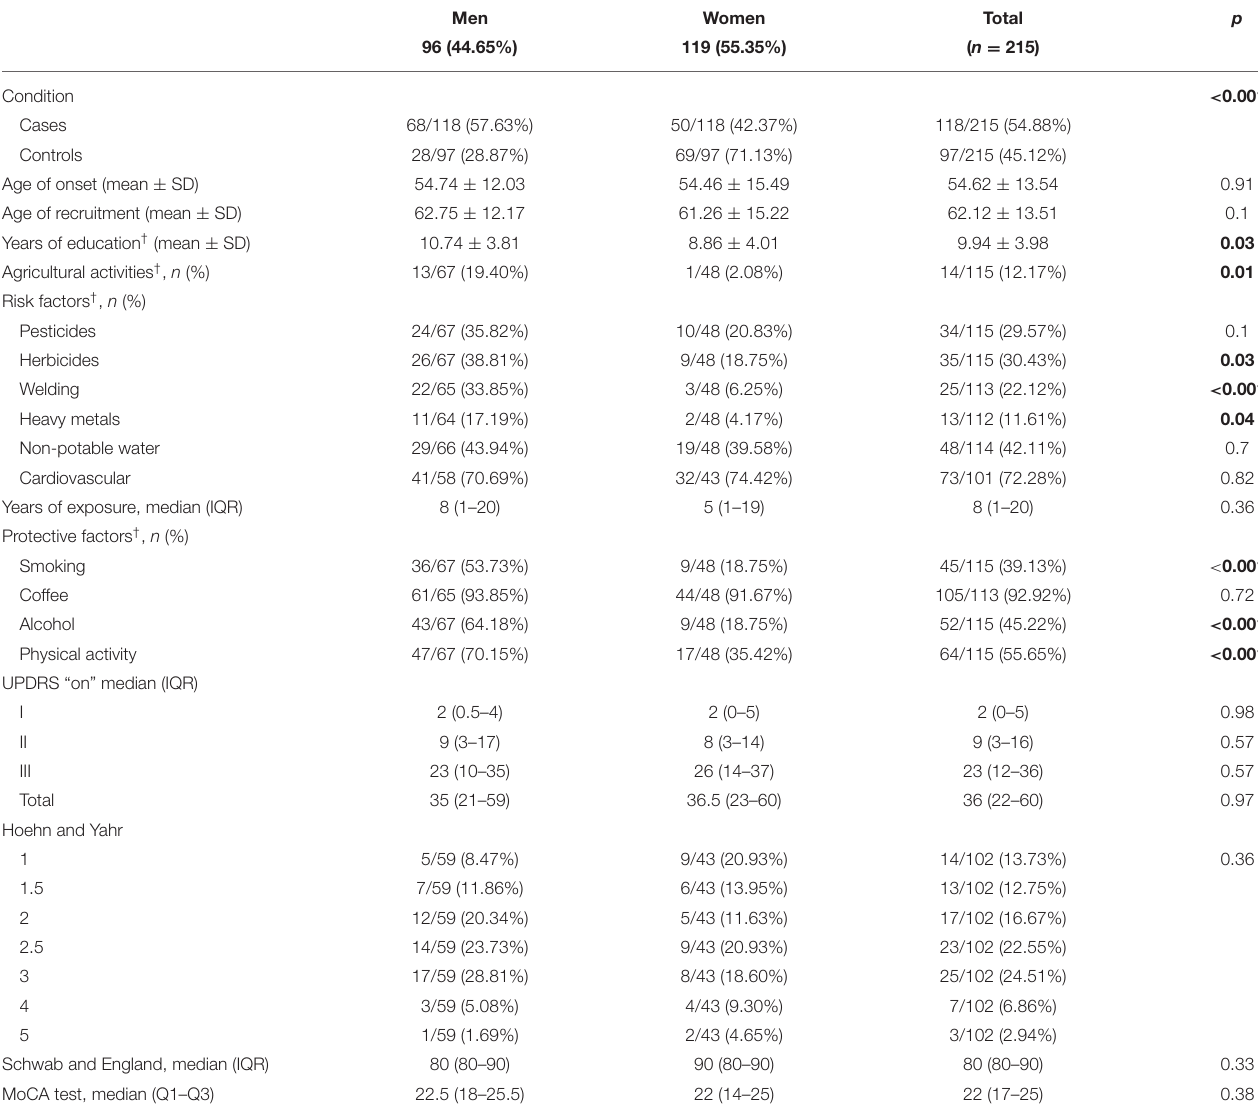
TABLE 1 | Baseline characteristics with frequency of risk and protective factors for PD in study subjects, with sex